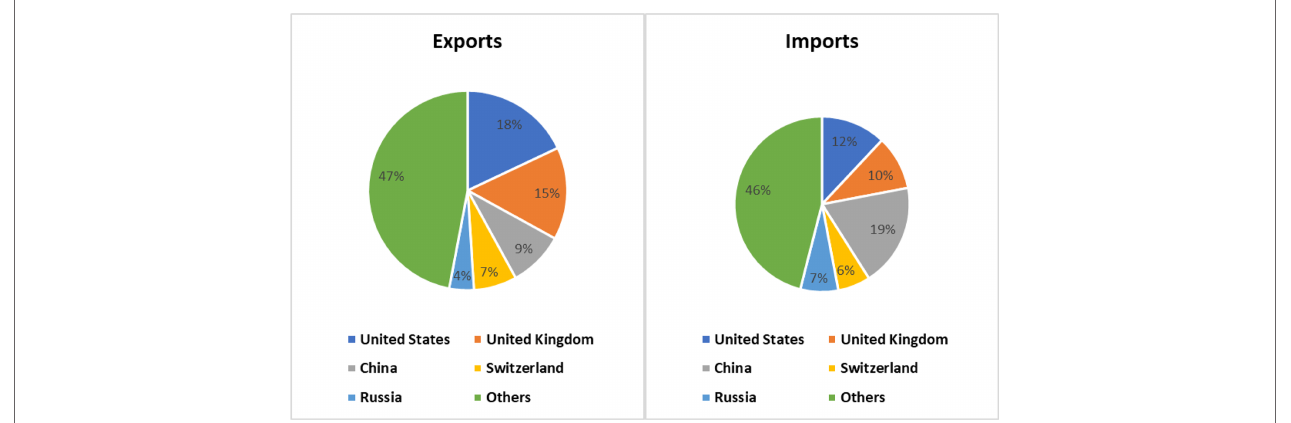
FIGURE 1 | EU-27 Trade Volume with China-2019. Source: European Commission (European Commission,